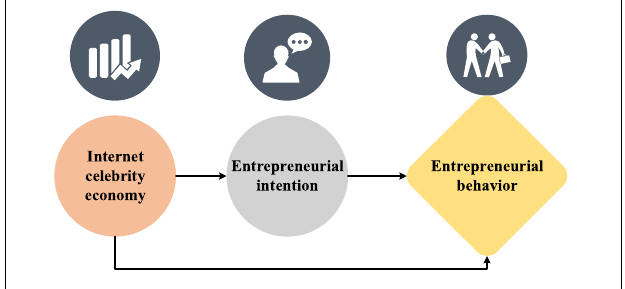
FIGURE 3 | Relationship among variables of Internet celebrity economy, entrepreneurial intention and entrepreneurial behavior.